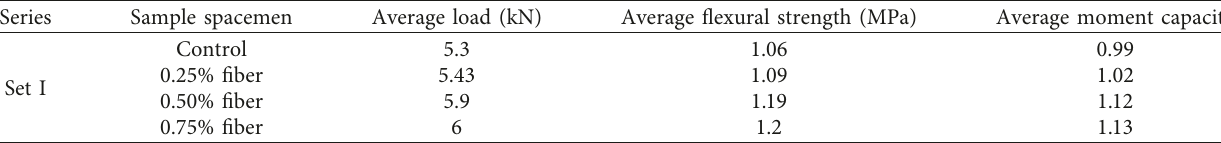
Table 3: Flexural strength of concrete 7 days test plain concrete beam samples.